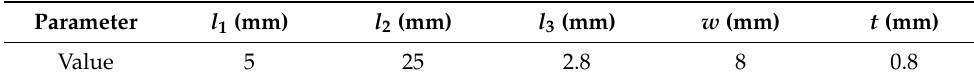
Figure 9. The bridge-type mechanism. Table 2. Main parameters of the bridge-type